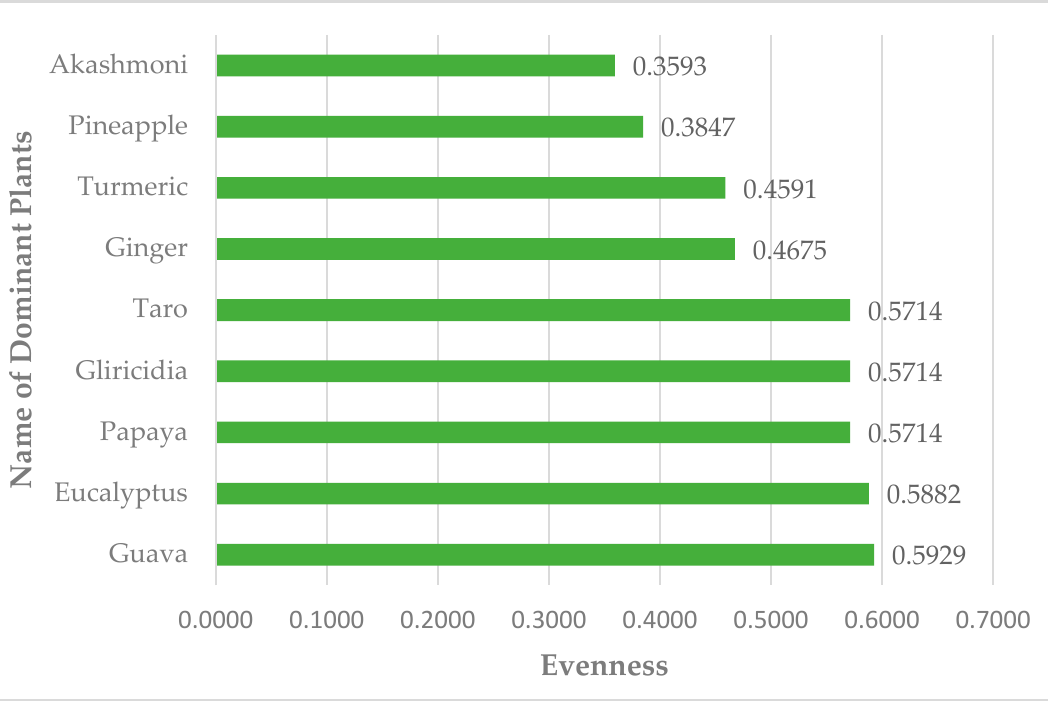
Figure 7. The Evenness of the dominant plant species in the Madhupur tract. 4. Discussion Around 40% of the terrestrial land area is covered by crop and pasture lands, and around 43% of the world’s cropland represents at least 10% of tree cover [40,41]. Thus, agroforestry has immense potential to conserve and enhance biodiversity. At the same